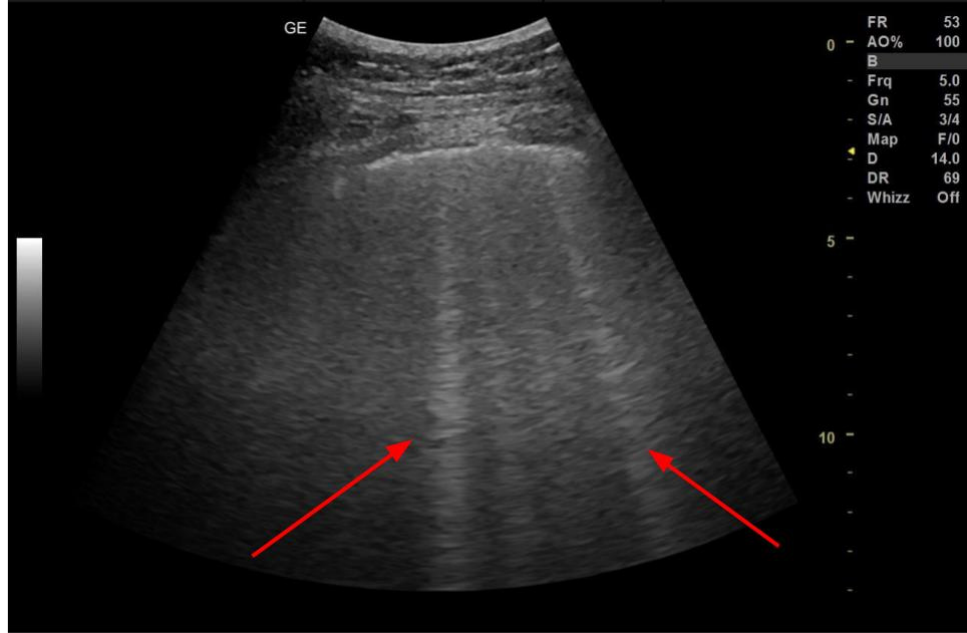
Figure 5. B-lines in LUS (Convex probe). Figure were acquired in the Department of Internal Medicine, Pulmonary Diseases and Allergy, Medical University of Warsaw.